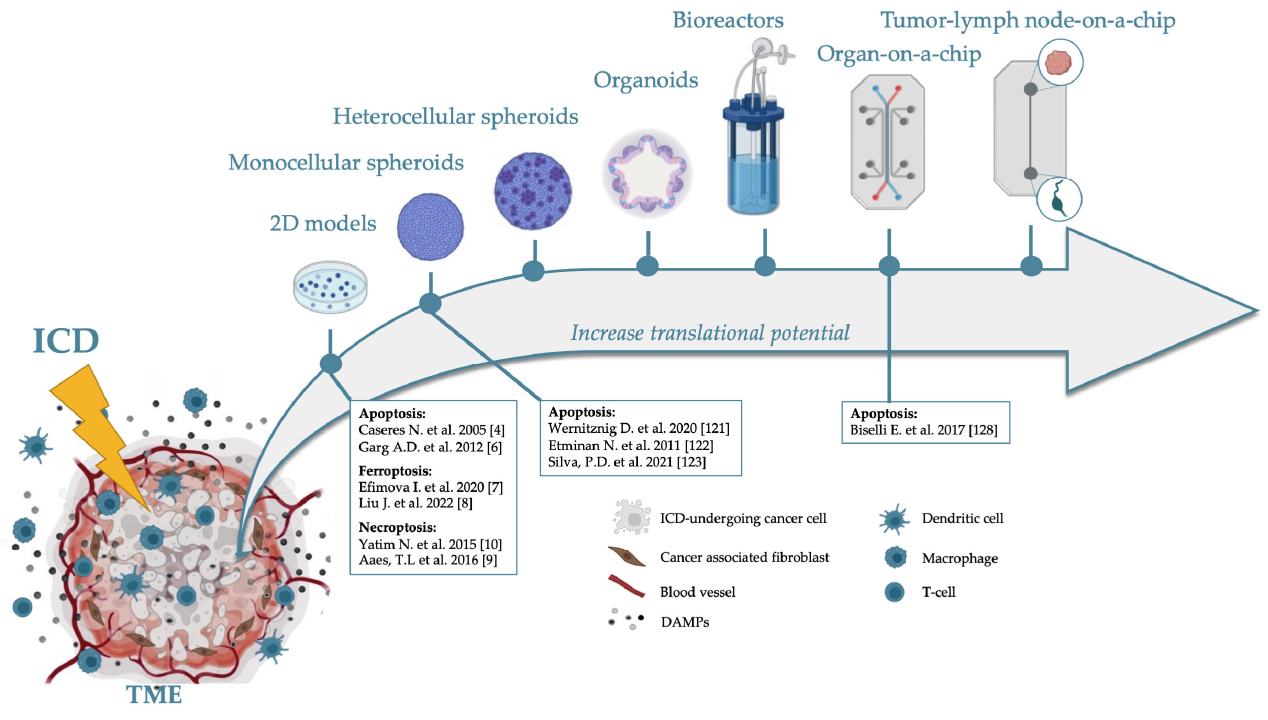
Figure 3. Available and implementable tumor models and devices used to study ICD within the